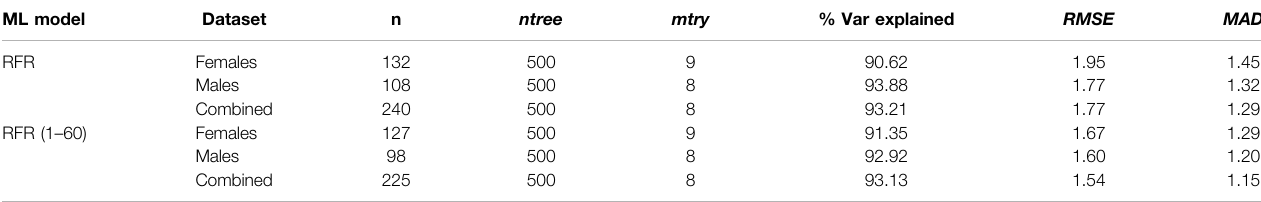
TABLE 3 | Detailed feature selection and model ef fi ciency information of random forest regression (RFR) models in three different gender datasets of the CHS cohort. ML model